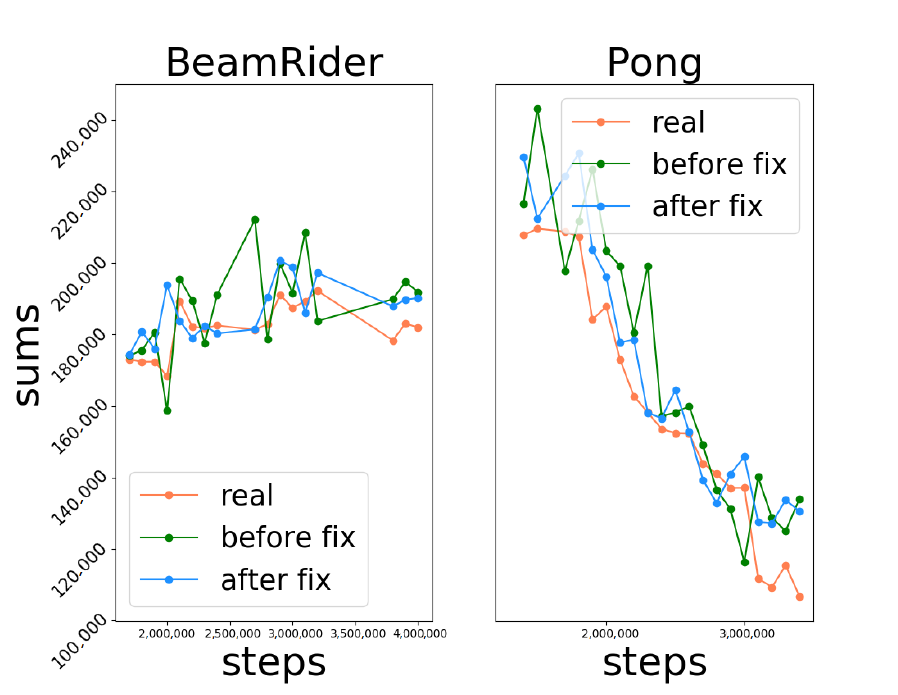
Figure 10. The accuracy of predicted TD-error’s sum on game BeamRider and Pong. The coral, green, and blue curves represent real, before fix model, and after fix model, respectively.